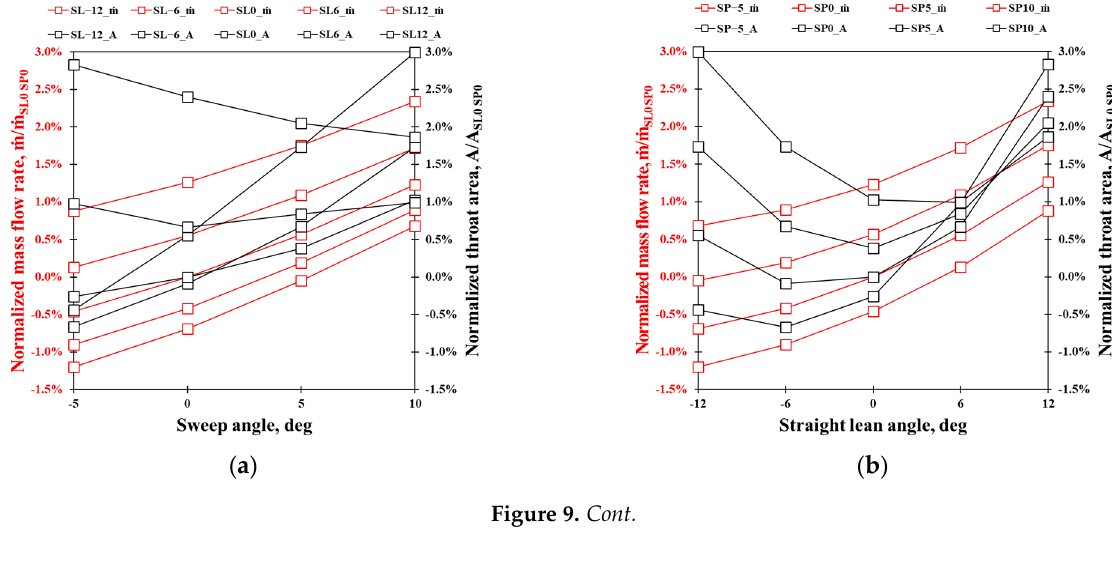
( d ) Figure 9. Variation of throat area and mass flow rate of the 3D NGVs: ( a ) Sweep with straight lean angle; ( b ) Straight lean with sweep angle; ( c ) Sweep with compound angle; ( d ) Compound lean with sweep angle. 3.2. Effect of Straight Lean, Compound Lean and Sweep There are early studies to investigate the influence of lean and sweep angles on tur- bine aerodynamics [21,22]. Prior to discuss about its combined effect and also swirl clock- ing, it will be worthwhile to observe the influence of straight lean, compound lean and sweep on the flow field of turbine passage. Figure 10 shows the distribution of total pres- sure loss coefficient varying those angles. The straight lean of +12° model shows reduction in loss at lower endwall region while the loss is increase near the upper endwall compares to the baseline model. The compound lean model with the same +12° minimizes the loss at the upper endwall region. By applying the sweep angle (10°), the level of loss near the upper endwall region is reduced but the wake is widely spread than the baseline model. The same trend is also observed for the swept airfoils with straight and compound lean angles.